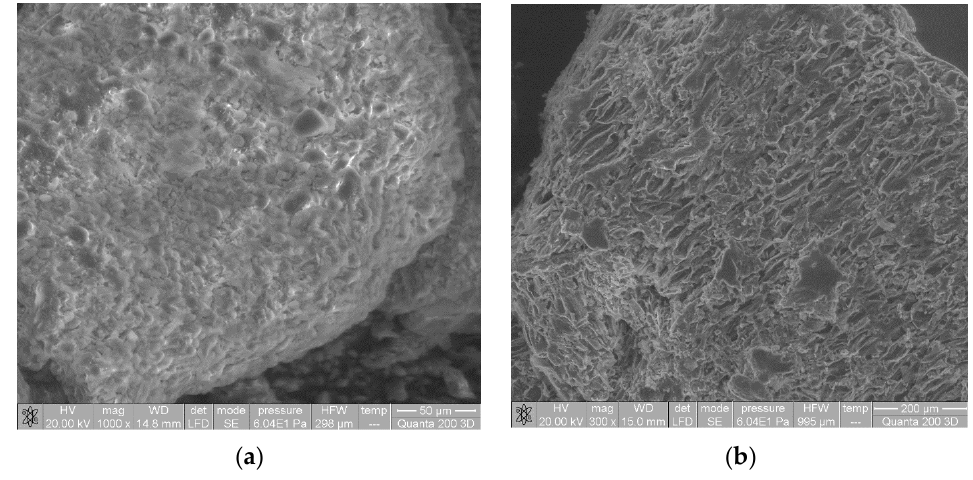
Figure 3. SEM images recorded for soybean biomass ( a ) and soybean waste ( b ).